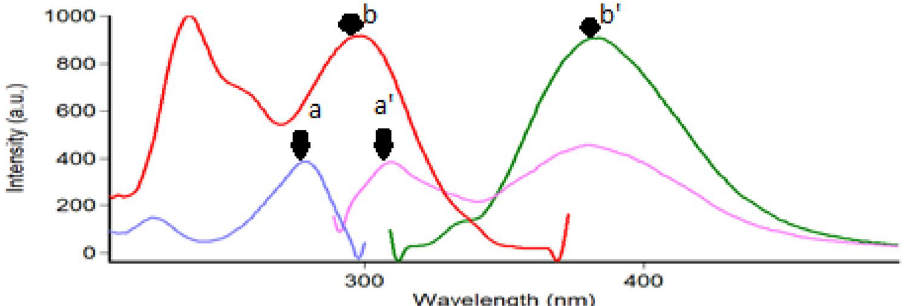
Figure 2. Excitation and emission spectra of NEB and TEL in acetate buffer of pH 4, where: (a, a´) : NEB(100.0 ng /mL) excitation and emission spectra.(b, b´) : TEL (30.0 ng/mL) excitation and emission